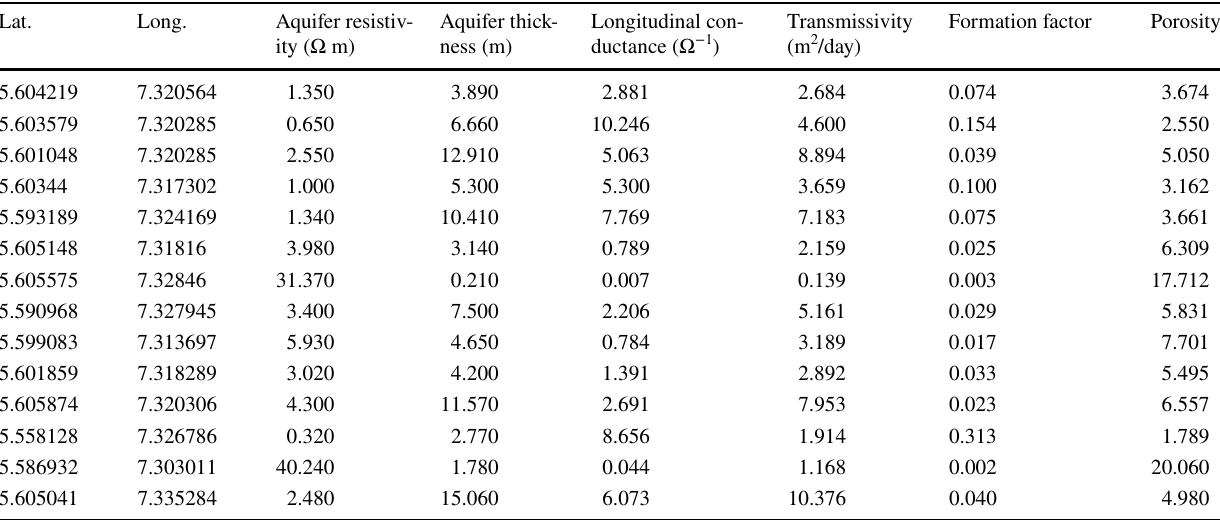
Table 1 Hydro-geophysical data of aquifer